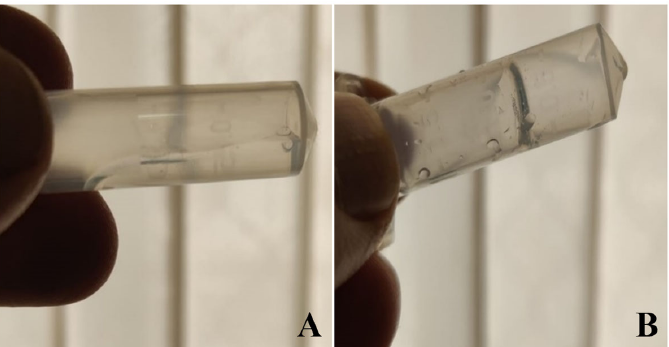
Figure 3. Image showing the flow properties of an optimized NEB-loaded dual-responsive in situ gel. ( A ) Free flowing properties at 25 °C suitable for easy and accurate dosing and ( B ) forming a firm gel at 34 ± 0.5 °C in presence of STF.